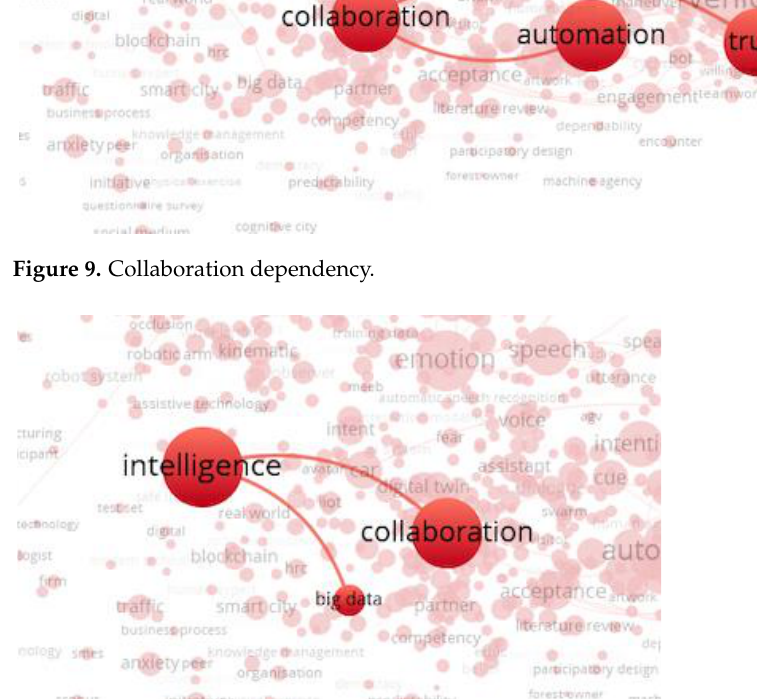
Figure 11. Automation dependency.